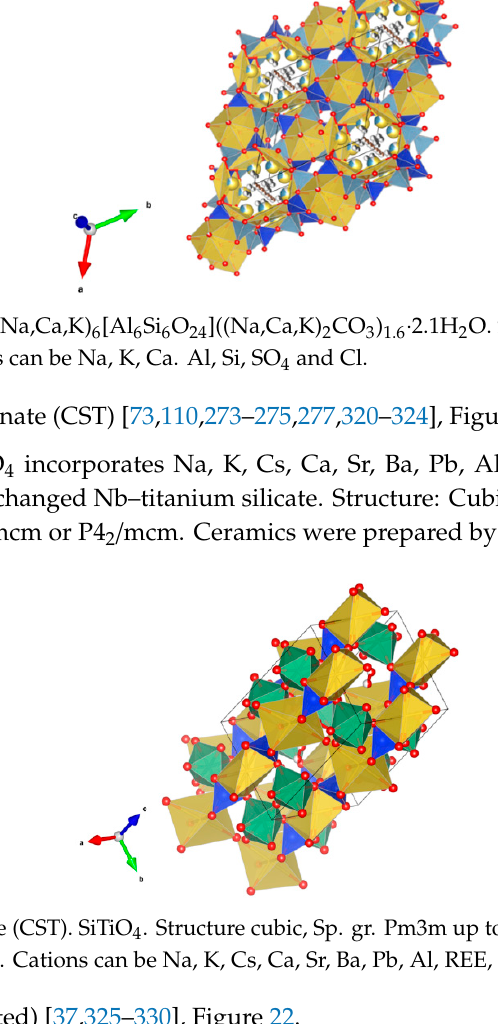
Figure 22. Micas (Dehydroxylated). XY 2–3 Z 4 O 10 (OH, F) 2 with X = K, Na, Ba, Ca, Cs, (H 3